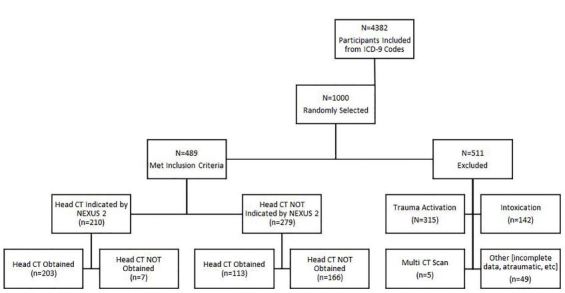
Eligibility criteria for inclusion in study examining providers’ adherence to (computed tomography ) CT decision rules in minor head injury.